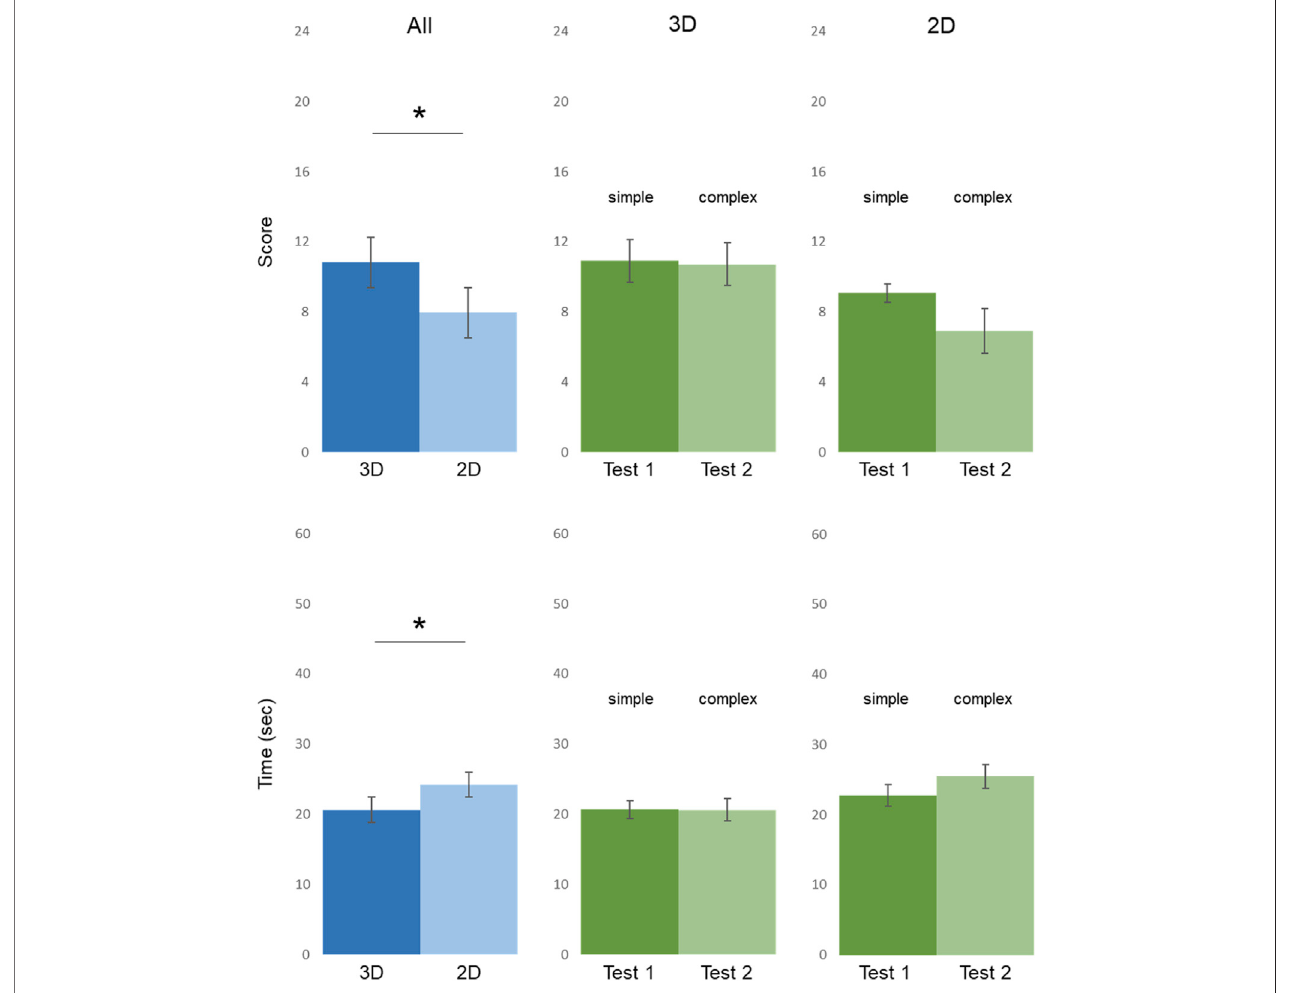
FIGURE 4 | Main effects of dimensionality for test score (A) and time (D) for all participants, and main effects of VE complexity (3D: (B,E) ; 2D: (C,F) ) on IMRT performance (score and average time per question). * p < .05. Error bars: SEM.